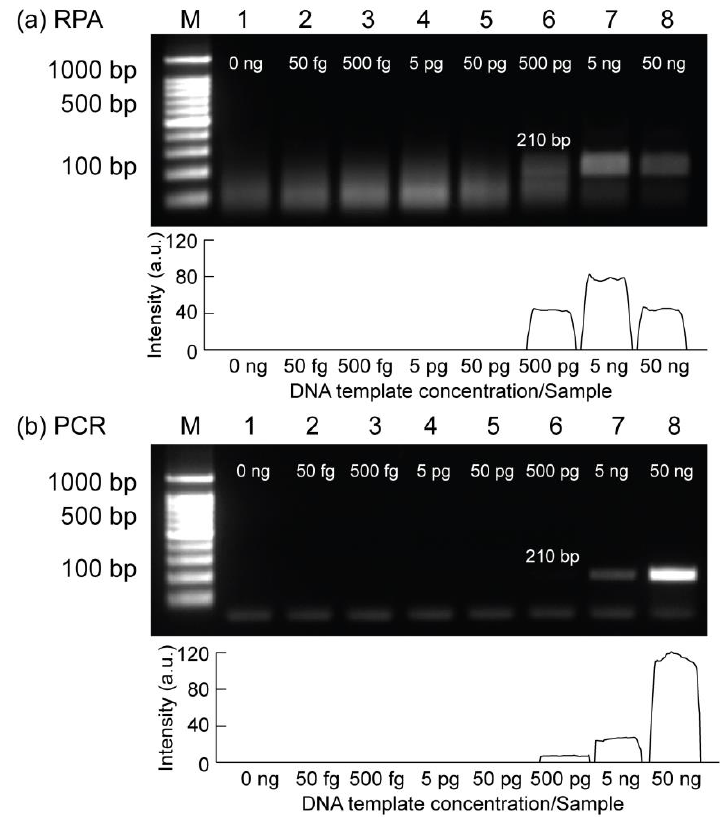
Figure 4. Results of gel electrophoresis showing the sensitivity using tenfold serial dilutions of gDNA input from E. coli O157:H7 bacteria. ( a ) On-tube RPA results. ( b ) On-tube PCR results. Lane M is the 100 bp DNA ladder. Lanes 1 – 8 show the amplification results when input gDNA concentrations were 50 fg to 50 ng/sample, respectively. Relative intensity scales of the target amplicons were shown below each gel image. All the experiments were repeated three times.